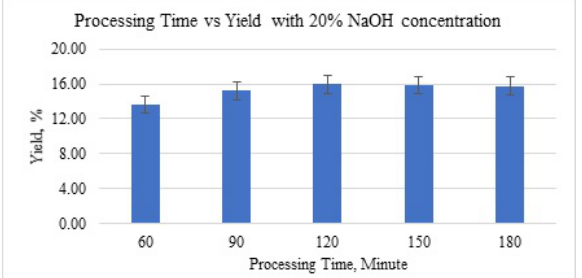
Fig. 1. The Correlation of Processing Time in the Delignification Process with Yield of Crude Extract Powder with 20% NaOH Solvent Concentration